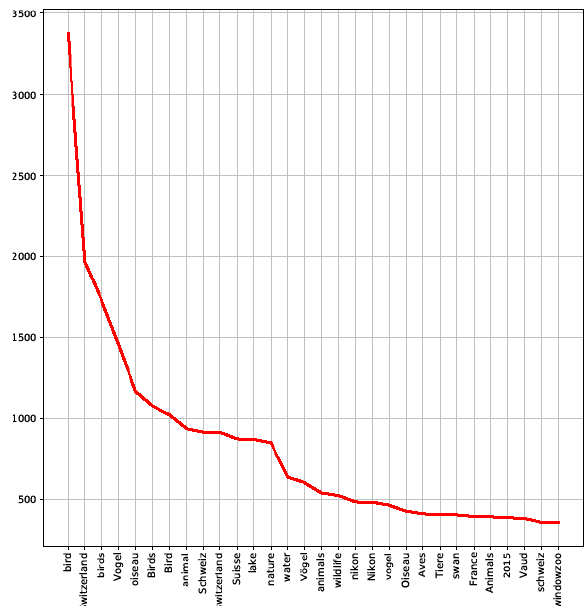
Figure 5: The most frequent tags from the downloaded Flickr images (x-axis: Flickr tags, y-axis: frequency of tags)